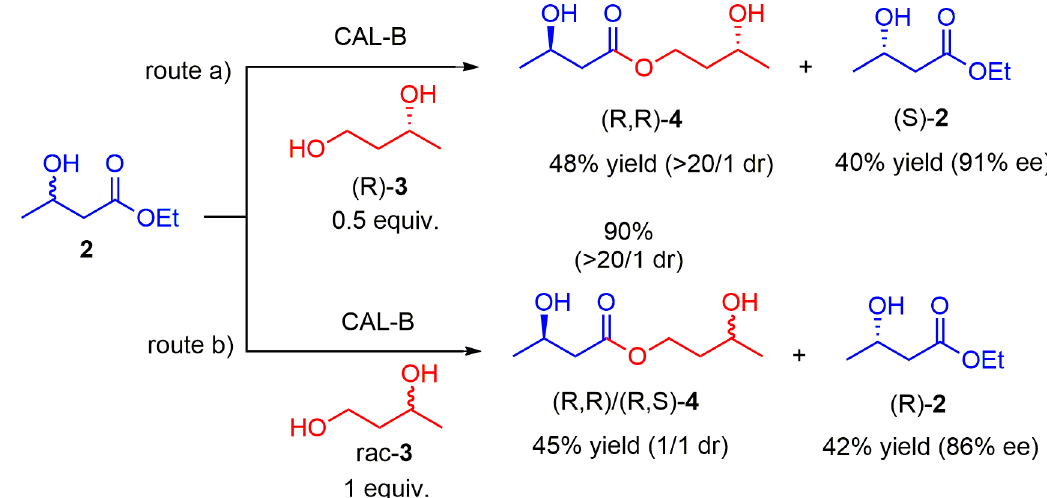
Figure 1. Time course of the CAL-B catalyzed kinetic resolution of racemic diol 3